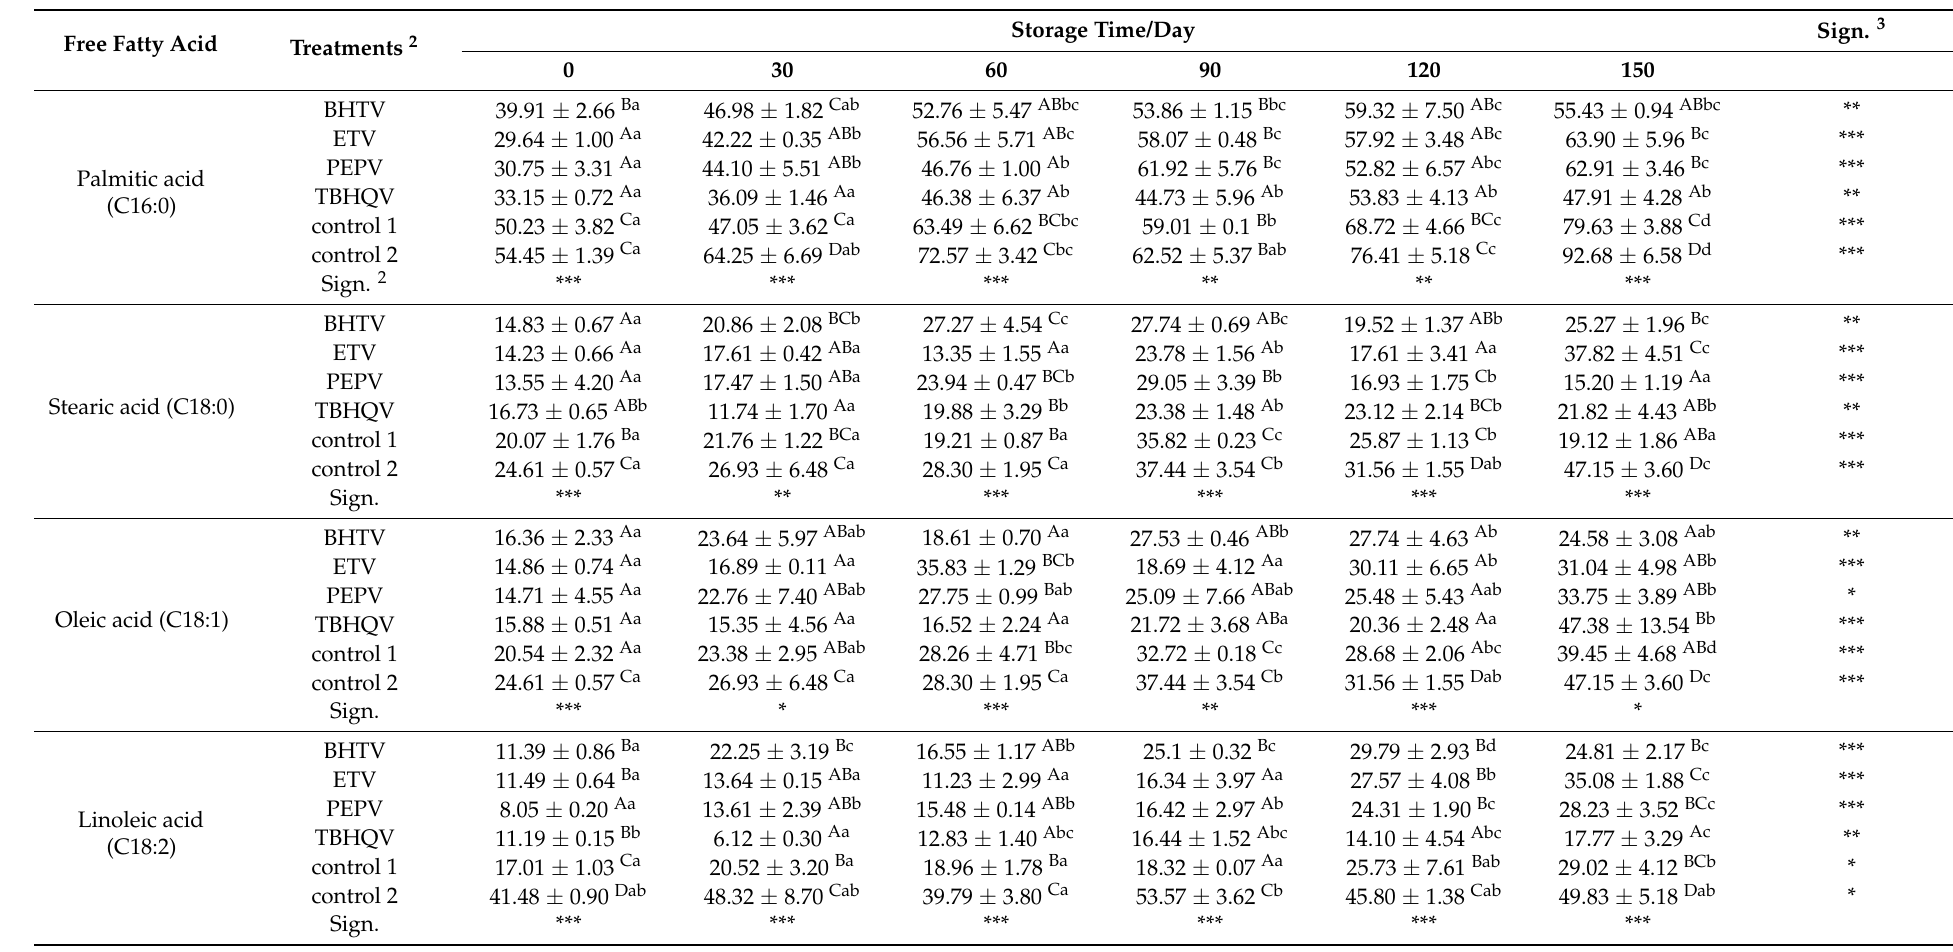
Table 3. The contents of free fatty acids (FFAs) in deep fired Gryllus bimaculatus during storage (mg/100 g) 1